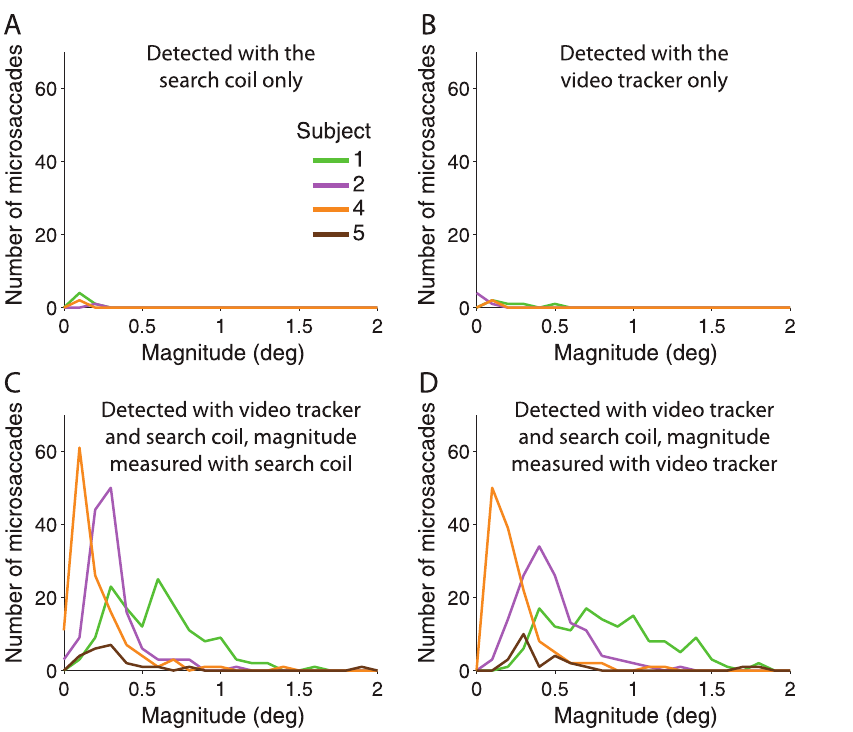
Fig 7. Magnitude distributions for microsaccades detected in only one recording system or in both systems. Magnitude distributions of microsaccades detected in only one system ( A – B ) or both systems ( C – D ). Detection system indicated at the top of each